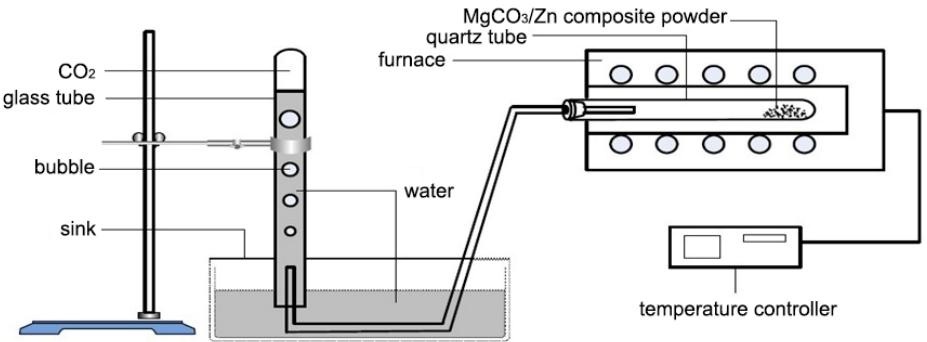
Figure 1. Diagrams of the experimental setup for the thermal decomposition of the MgCO 3 /Zn composite powder.